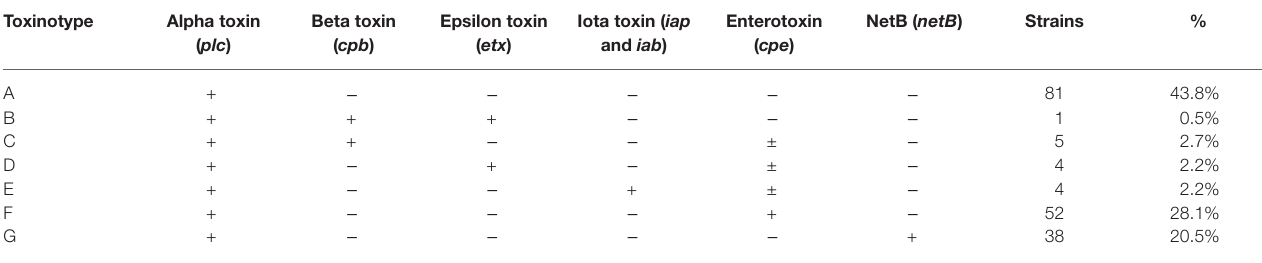
TABLE 2 | Toxinotypes of 185 C. perfringens genomes based on the typing scheme of Rood et al. (2018).